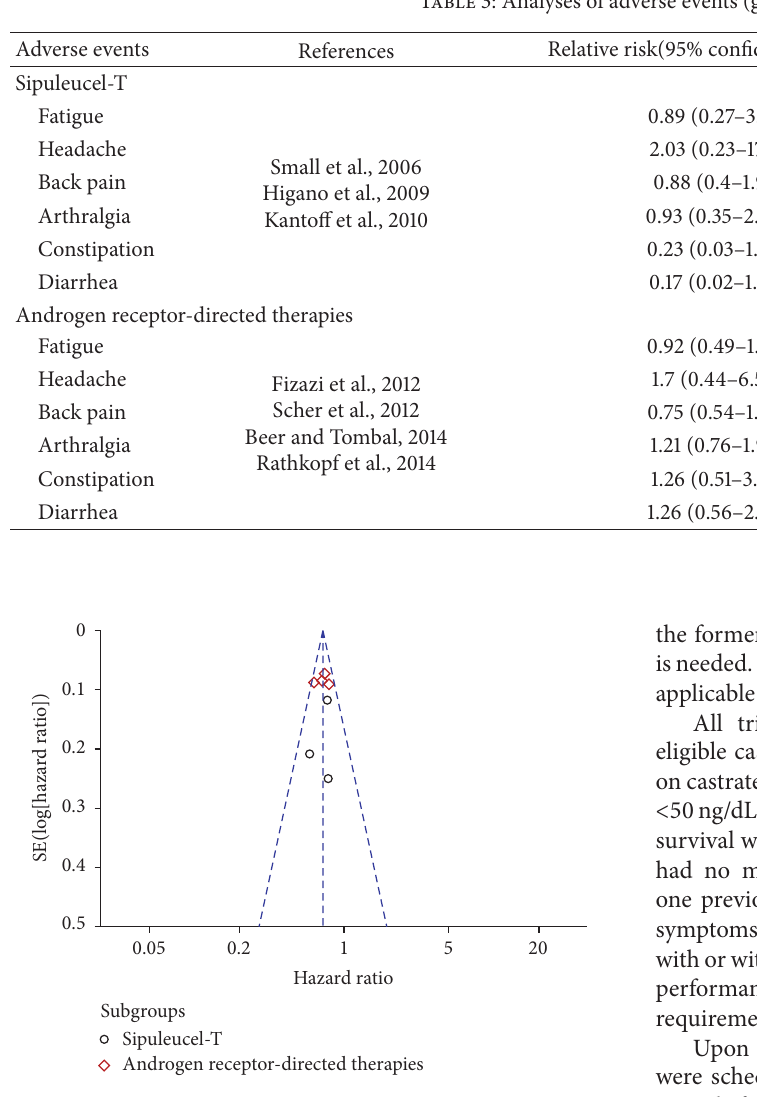
Figure 6: Funnel plot on overall survival for all included studies. The funnel graph plots the log of HR against the standard error of the log of the OR. The circles indicate the individual studies in the meta-analysis. The line in the center represents the meta